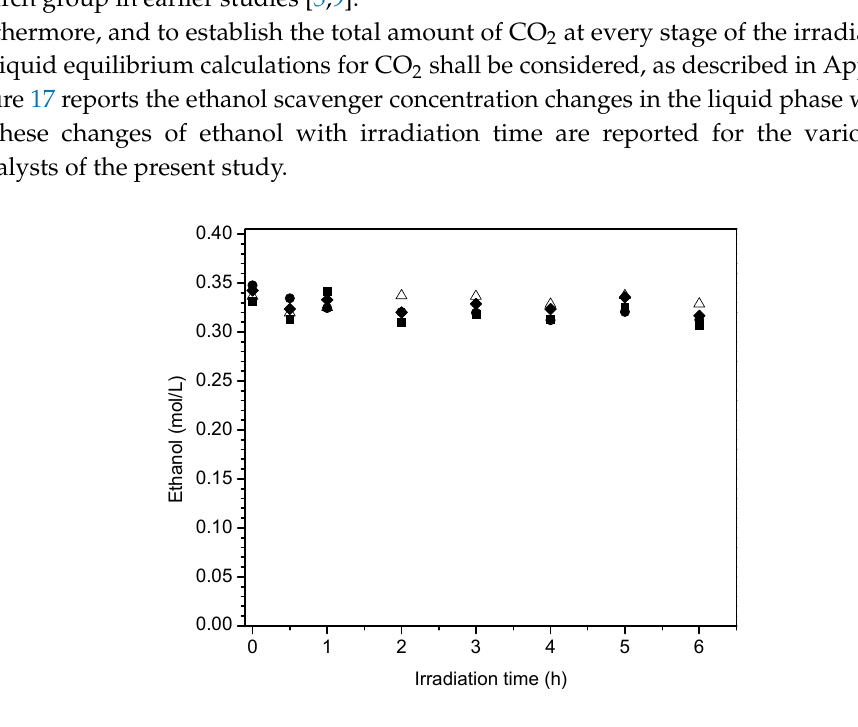
Figure 17. Ethanol concentration changes with irradiation time for: ( ● ) 2.50 wt % Pt–TiO 2 (sol-gel B), ( (cid:4) ) 1.70 wt % Pt–TiO 2 (sol-gel A), ( (cid:7) ) 1.70 wt % Pt–TiO 2 (wetness impregnation) and ( ∆ ) Degussa P25. ( ■ ) 1.70 wt. % Pt–TiO 2 (sol-gel A), ( ♦ ) 1.70 wt. % Pt–TiO 2 (wetness impregnation) and ( ∆ ) Degussa Notes: Initial ethanol concentration: 2.00% v / v or 0.345 P25. Notes: a) Initial ethanol concentration: 2.00% v / v or 0.345 mole/L.